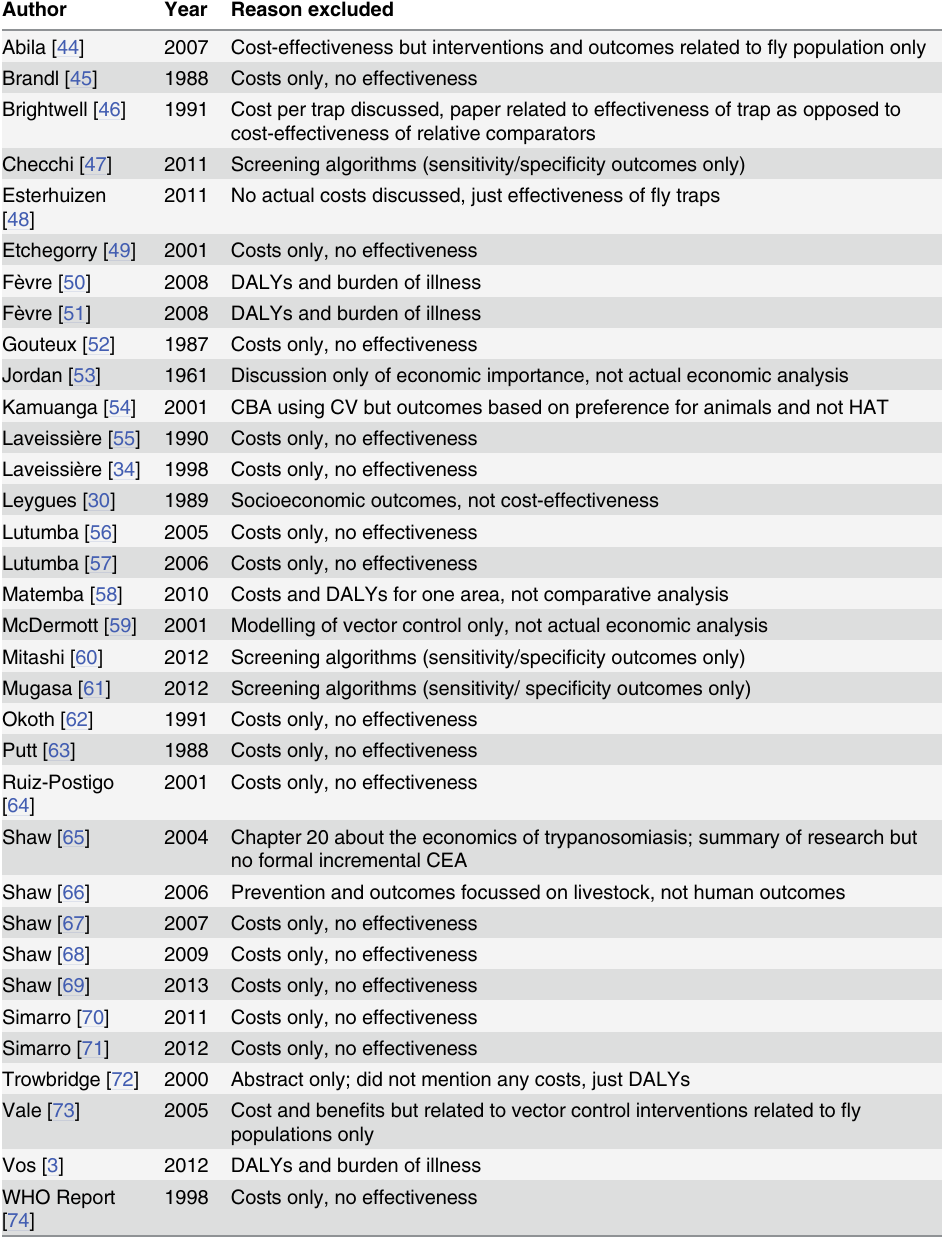
Table 1. Characteristics of excluded studies at second-level